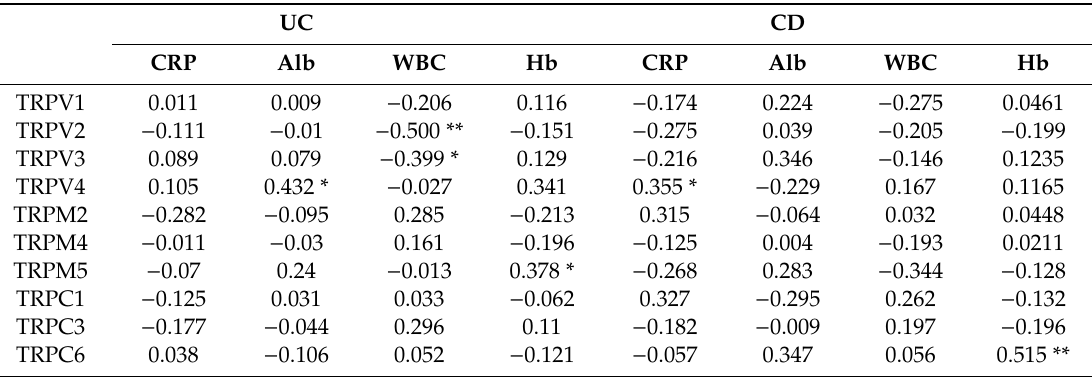
Table 3. Correlation coe ffi cients and significance of di ff erences between each transient receptor potential (TRP) channel expression and laboratory parameters in patients with ulcerative colitis (UC) or Crohn’s disease